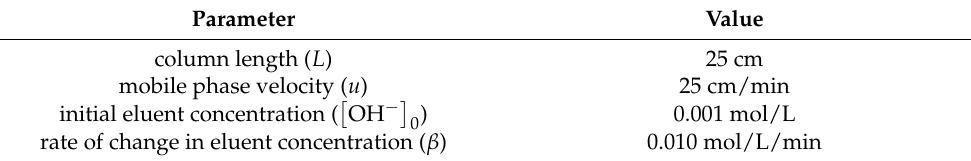
Table 1. The numerical parameters required for numerical calculations and their respective values. Parameter Value column length ( L ) 25 cm mobile phase velocity ( u )